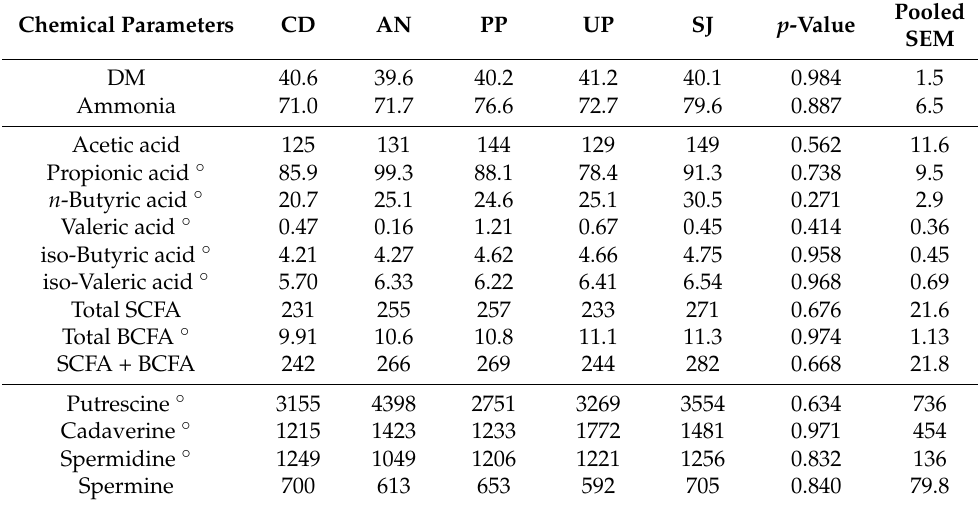
Table 3. Fecal dry matter (DM) percentage and concentrations of fecal ammonia, SCFAs,